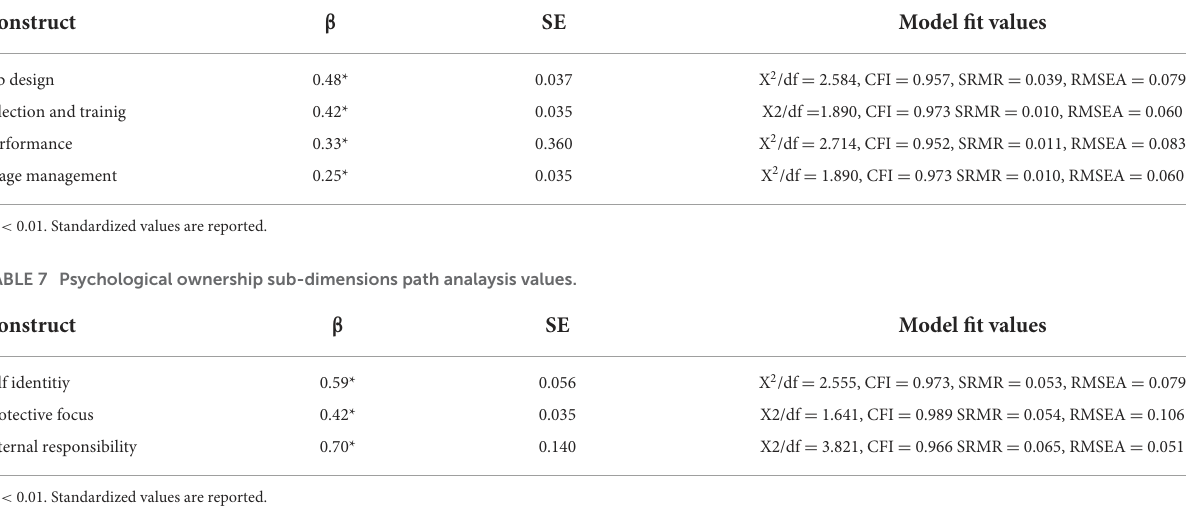
TABLE 6 GHRM sub-dimensions–psychological ownership path analaysis values.